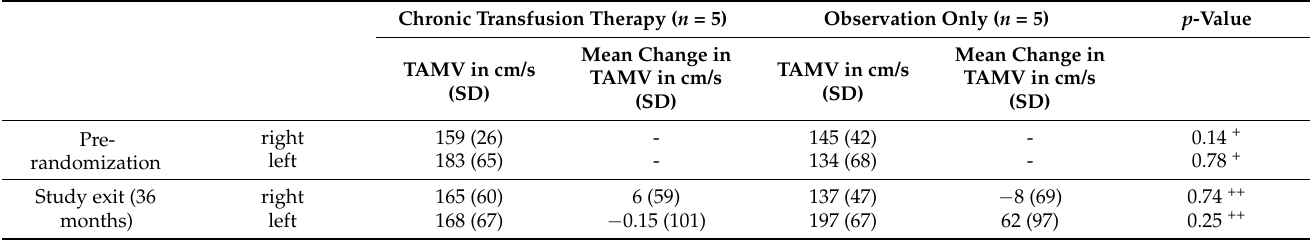
Table 1. Comparison of changes in time averaged mean velocity (TAMV) in observation and chronic RBC transfusion